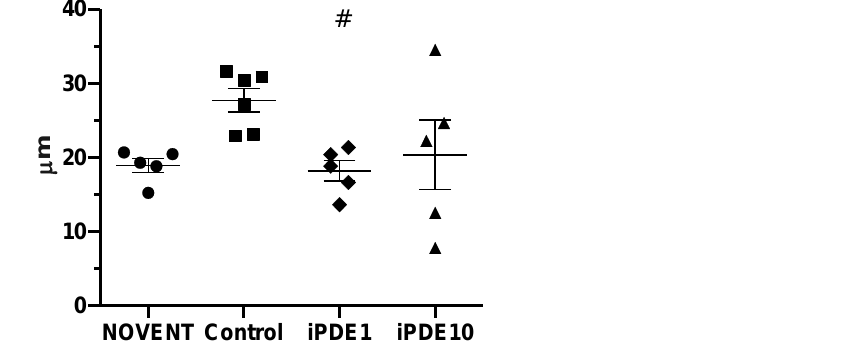
Figure 4. MLI in µm was significantly lower in iPDE1 animals compared to control ( # p < 0.05 vs. control), whereas the iPDE10 group showed a high individual spread within this group. Table 1. Stereology of the lung in 15 of 21 animals (data given as mean ± SEM, * p < 0.05 vs.